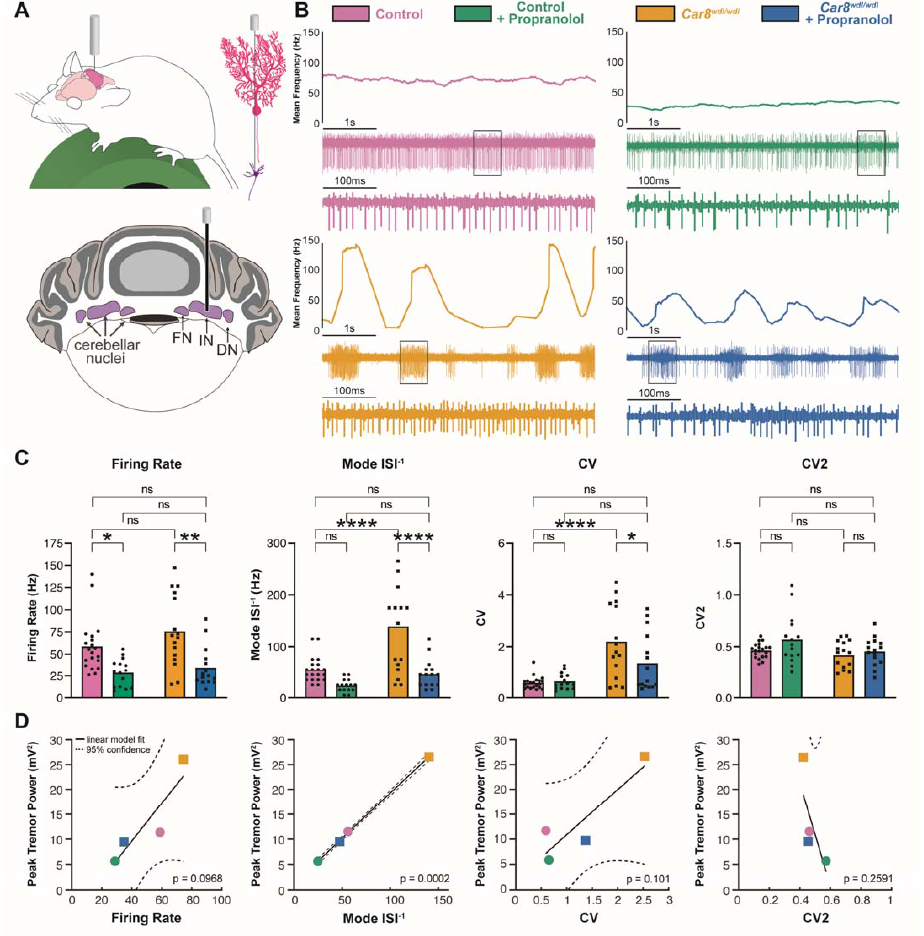
Figure 4. Propranolol modulates cerebellar nuclei neuron firing activity. ( A ) Top, schematic of awake in vivo electrophysiology recording setup. Illustrations of a Purkinje cell (bright pink), and downstream cerebellar nuclei neuron (purple) are shown. Bottom, schematic of a coronal mouse cerebellar section with the cerebellar nuclei outlined in purple. Recordings were conducted in the interposed nucleus (IN) as shown with the electrode placement. FN = fastigial nucleus, DN = dentate nucleus. ( B ) Representative raw electrophysiological traces of cerebellar nuclei neuron activity in a control mouse before (pink, N = 6, n = 20) and after propranolol treatment (green N = 6, n = 15), and in a Car8 wdl/wdl mouse before (gold, N = 6, n = 15) and after propranolol treatment (blue, N = 6, n =15). The line graph shown at the top for each condition represents the mean firing rate in Hz at each point in time for the 5 s spike traces shown below each line graph. Below the 5 s spike traces are magnified views of the spikes within the outlined boxes, spanning 500 ms. The same color assignment for each group is maintained throughout the remaining figure panels (legend above electrophysiology